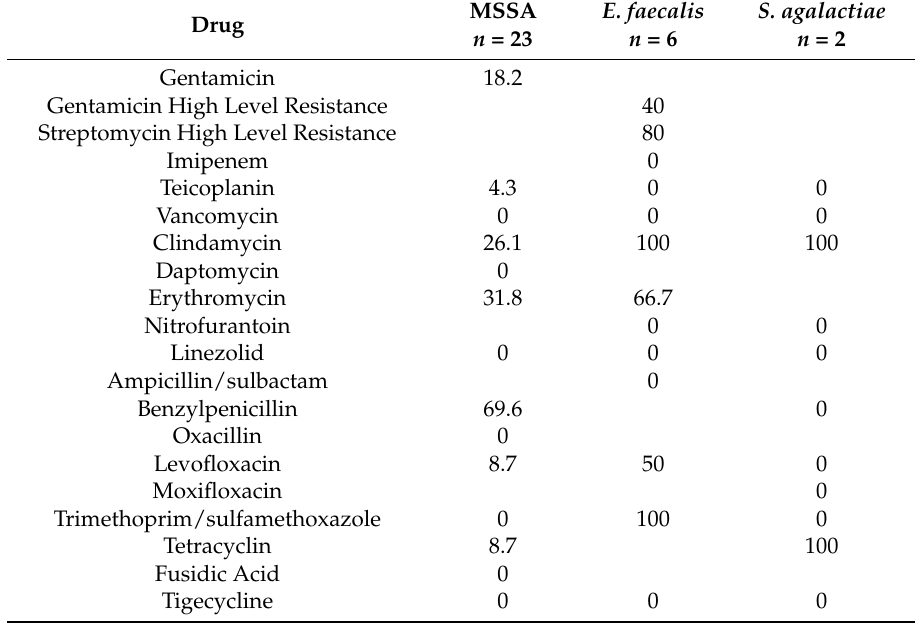
Table 2. Antibiotic resistance pattern of Gram-positive cocci not MDR (% of